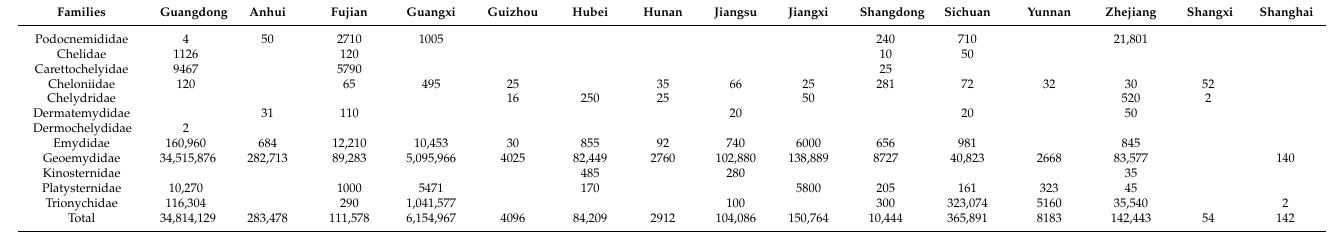
Table 3. The number of cultured turtles in various provinces/municipalities investigated.